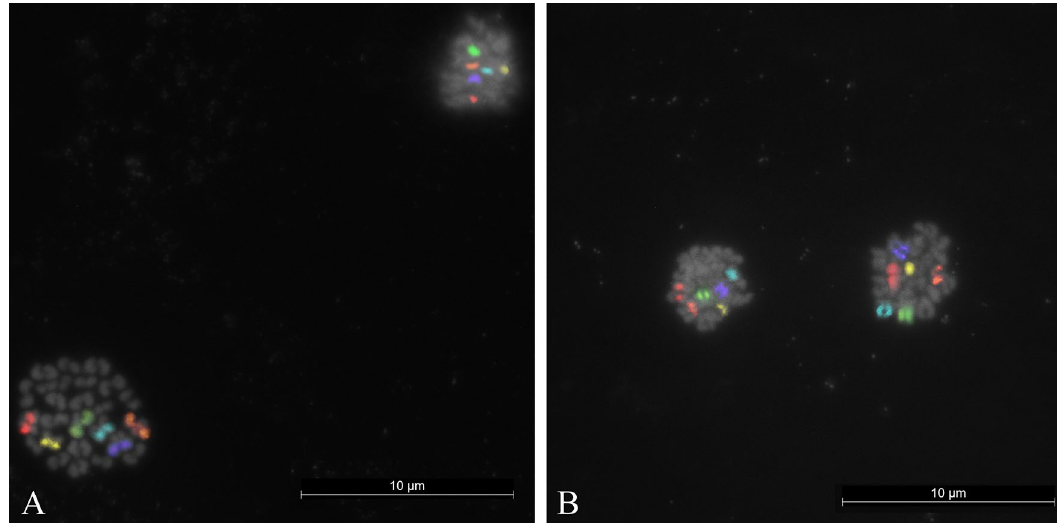
Figure 2. Multi-colour FISH showing the six signals in both metaphases and corresponding first polar bodies of in vitro-matured secondary oocytes as indication of a normal chromosomal segregation in ( A ) river buffalo (MII,25,X); ( B ) swamp buffalo (MII,24,X).